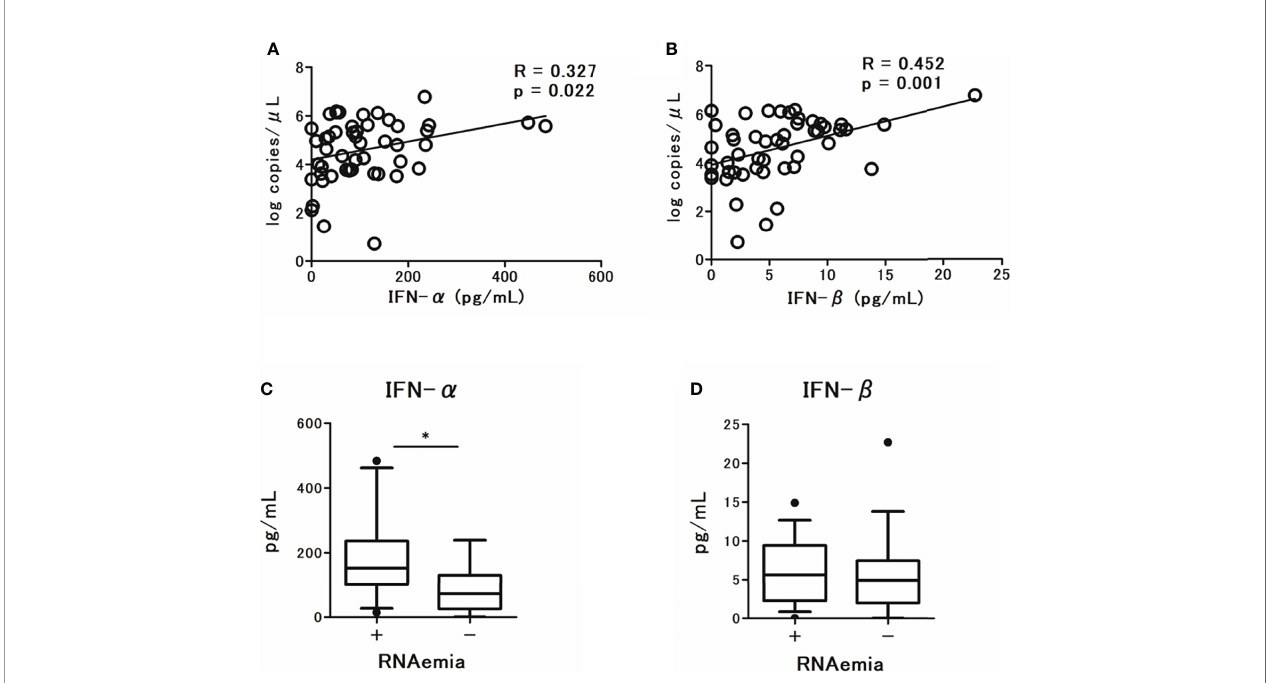
FIGURE 2 | Correlations between serum type I Interferon (IFN-I) levels and SARS-CoV-2 viral load in nasal swab specimens from patients with COVID-19: (A) IFN- a levels and (B) IFN- b levels. Spearman correlation test was used, and Spearman correlation coef fi cient is shown. Corresponding logarithmic trendlines are shown. Serum IFN-I levels in patients with COVID-19 and the association with RNAemia, (C) IFN- a levels, (D) IFN- b levels. Each level was measured at the time of admission (within 5 days after the onset of symptoms). Data are presented as Tukey boxplots and individual values. Nonparametric Mann-Whitney test was used to compare values between groups: *p < 0.05.